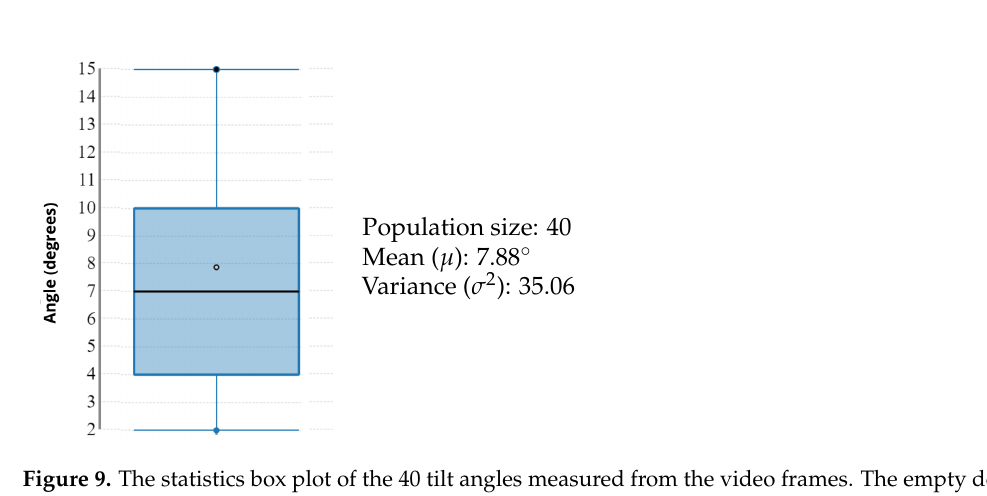
Figure 9. The statistics box plot of the 40 tilt angles measured from the video frames. The empty dot represents the mean and the black segment represents the median.